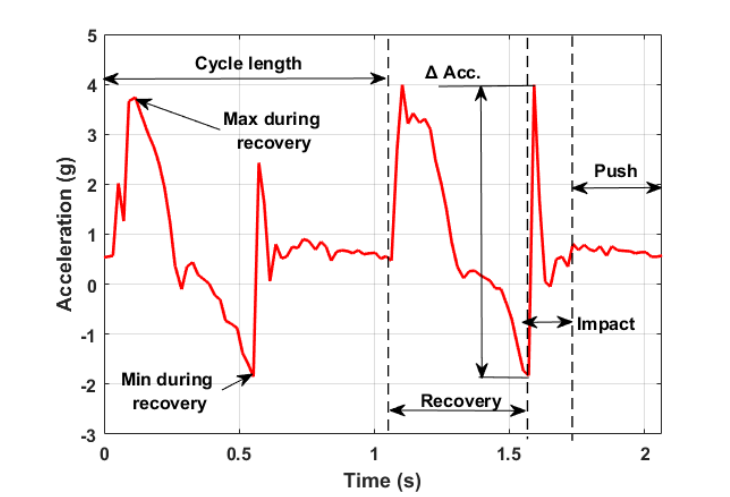
Figure 5. Typical longitudinal acceleration output measured by the acquisition